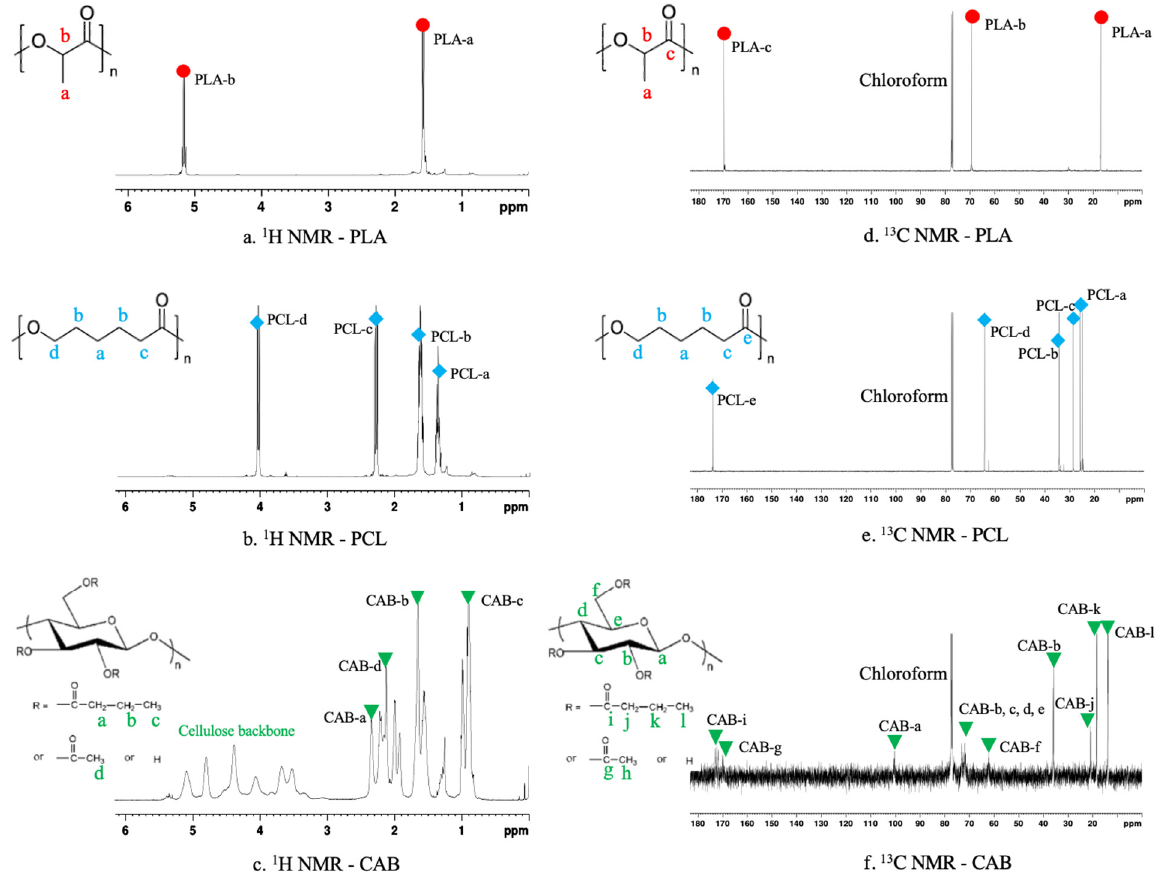
Figure 10. 1 H NMR ( a – c ) and 13 C NMR ( d – f ) of PLA, PCL and CAB.